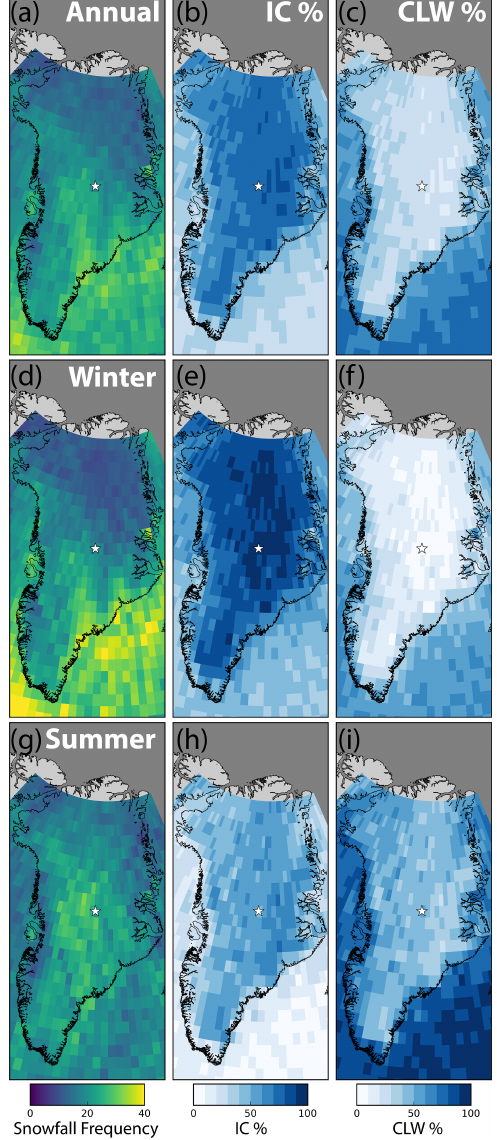
Figure 2. Snowfall frequency over the GrIS defined as observations of snowfall divided by total observations in each grid box. Panel (a) is annual mean snowfall frequency using all observations from the study period, panel (b) is the percentage of total snowfall observa- tions that were coincident with ice-phase clouds, and panel (c) is the percentage of the total snowfall observations that were coincident with clouds containing liquid water. Panels (b) and (c) sum to 100. Panel (d) is winter mean snowfall frequency (October–April), with panels (e) and (f) the percentages of winter snowfall coincident with ice-phase clouds and clouds containing liquid water, respectively. Panel (g) is summer mean snowfall frequency (May–September), with panels (e) and (f) the percentages of summer snowfall coinci- dent with ice-phase clouds and clouds containing liquid water, re- spectively. The location of Summit Station is marked in each panel by a white